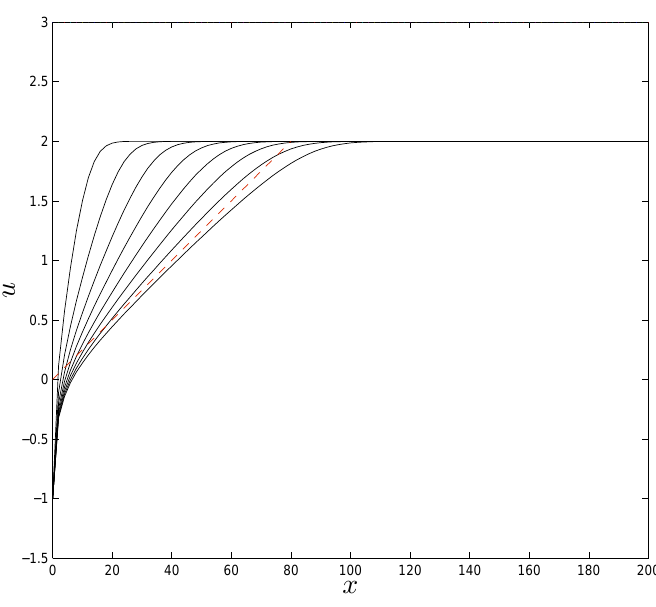
Figure 7: The occurrence of EW and SS with the solid lines show numerically computed solutions and the dash line representing the predicted slope at t = 40 .